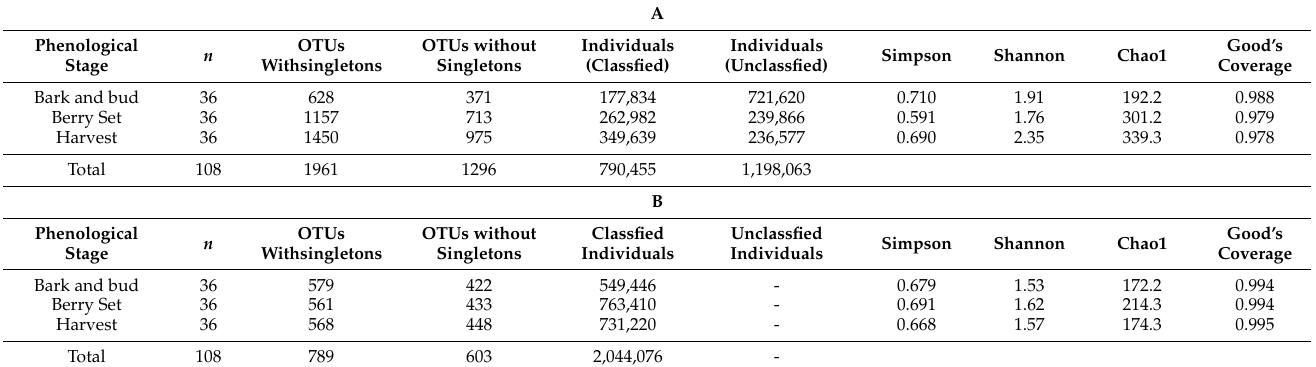
Table 1. Bacterial ( A ) and fungal ( B ) Sequence Analysis: number of samples analyzed ( n ), number of OTUs with and without singletons detected, classified and unclassified individuals, alpha diversity indices (Simpson, Shannon, Chao1), in the three phenological stages.